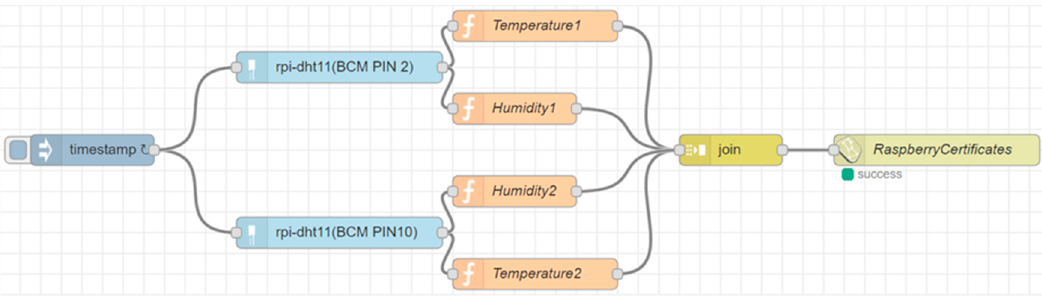
Figure 2. Example flow that sends data from two DHT11 sensors (humidity and temperature) to a Fiware Orion Broker.